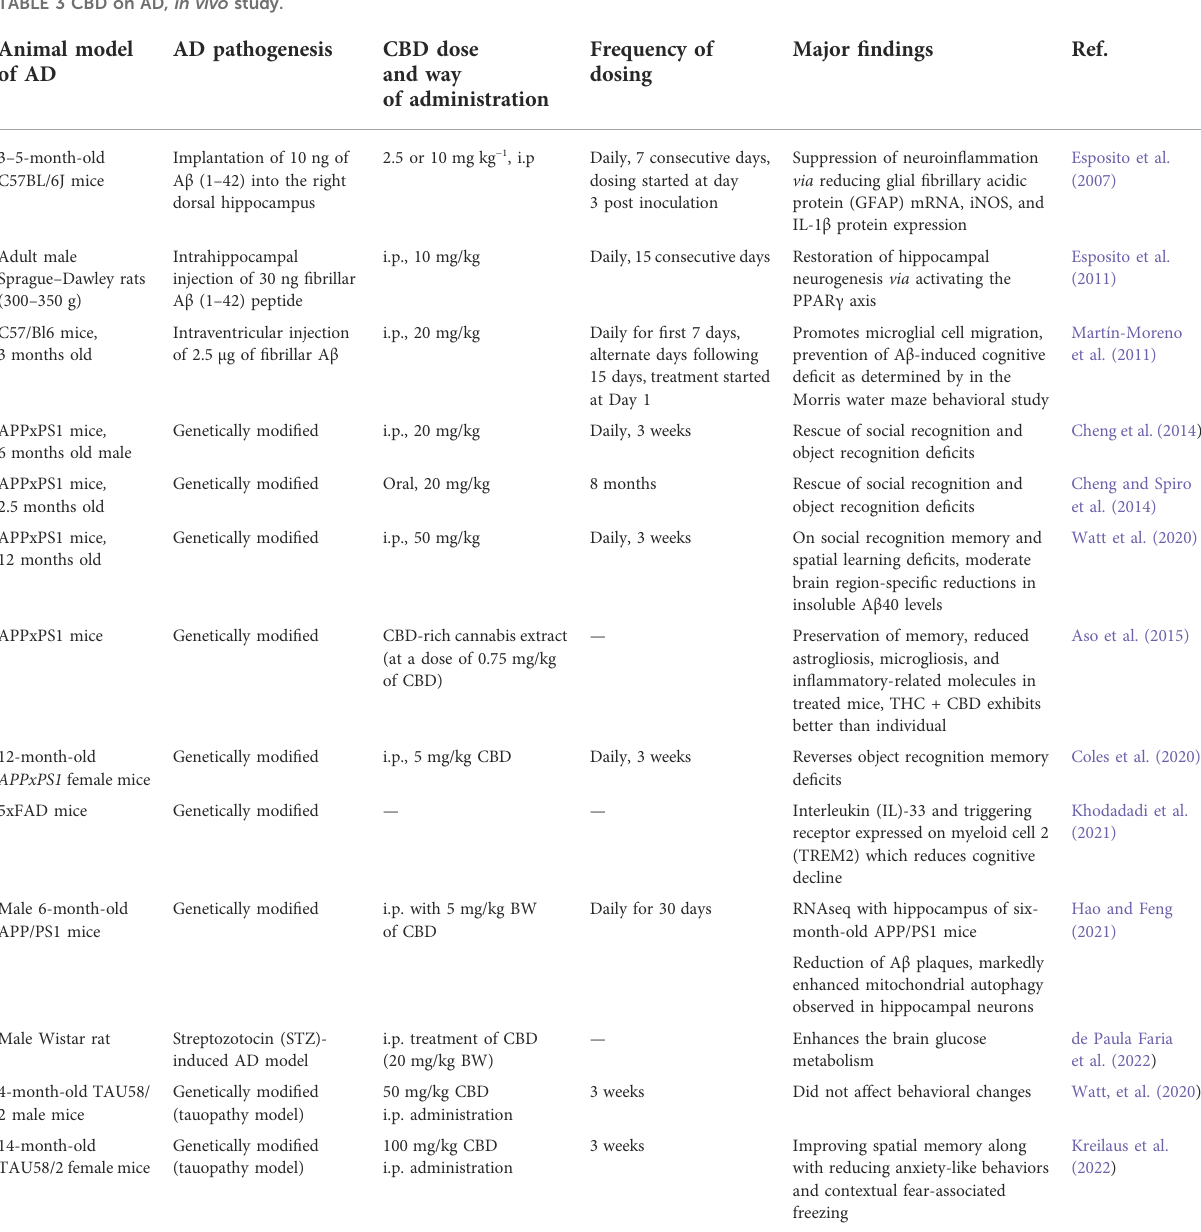
TABLE 3 CBD on AD, in vivo